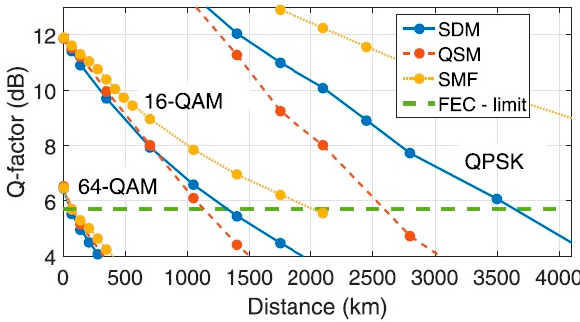
Figure 37. Q-factors for 64QAM, 16QAM, and QPSK [50].